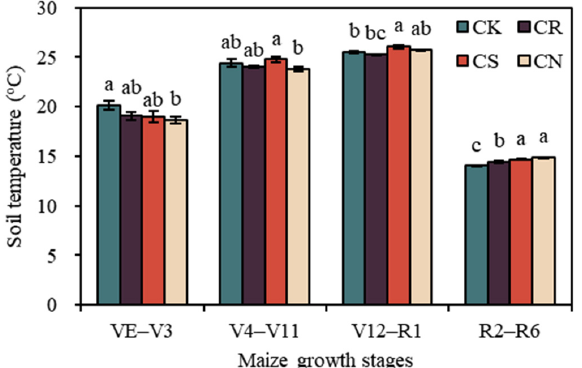
Figure 5. Soil mean temperature at a 5 cm soil depth as affected by tillage regimes during the maize growth period in 2021. CK, rotary tillage without straw returning; CR, rotary tillage with straw incorporation; CS, subsoiling tillage with straw mulching; CN, no tillage with straw mulching. Bar means the standard error. Different letters among the treatments indicate a significant difference at p < 0.05. VE, seed emergence; Vi, nth leaf; R1, silking stage; R2, blister stage; R6, physiological maturity.